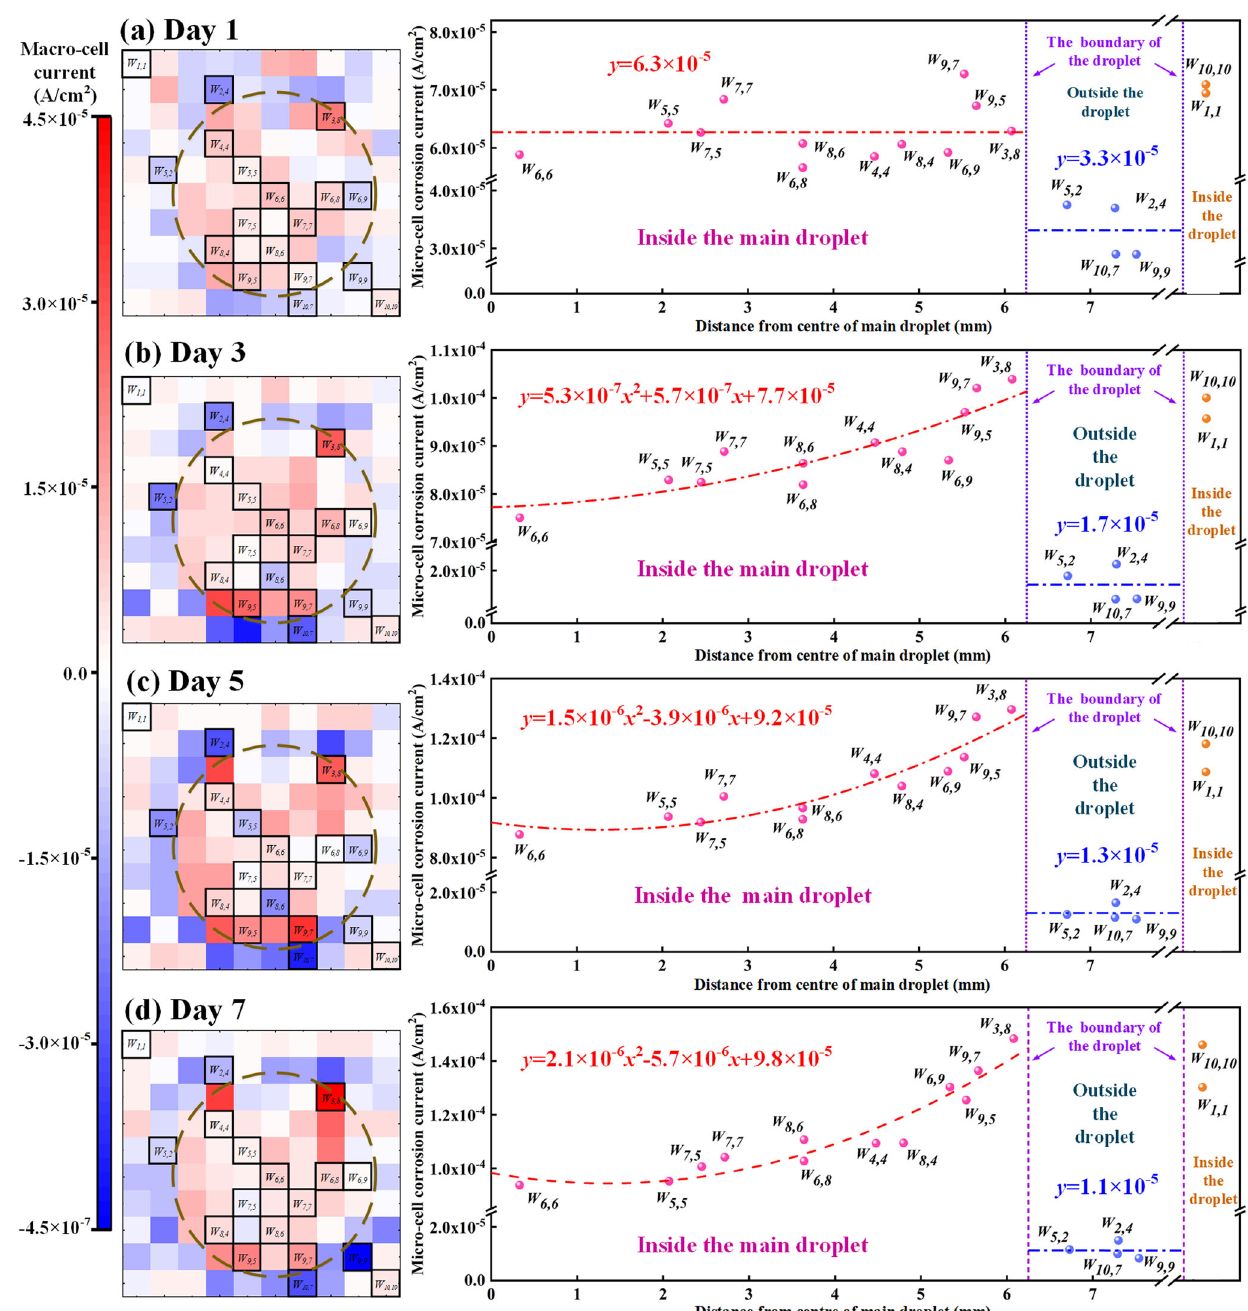
Fig. 4 The selection and local electrochemical measurements of the typical wire electrodes at different locations of WBE. a Day 1, b Day 3, c Day 5 and d Day